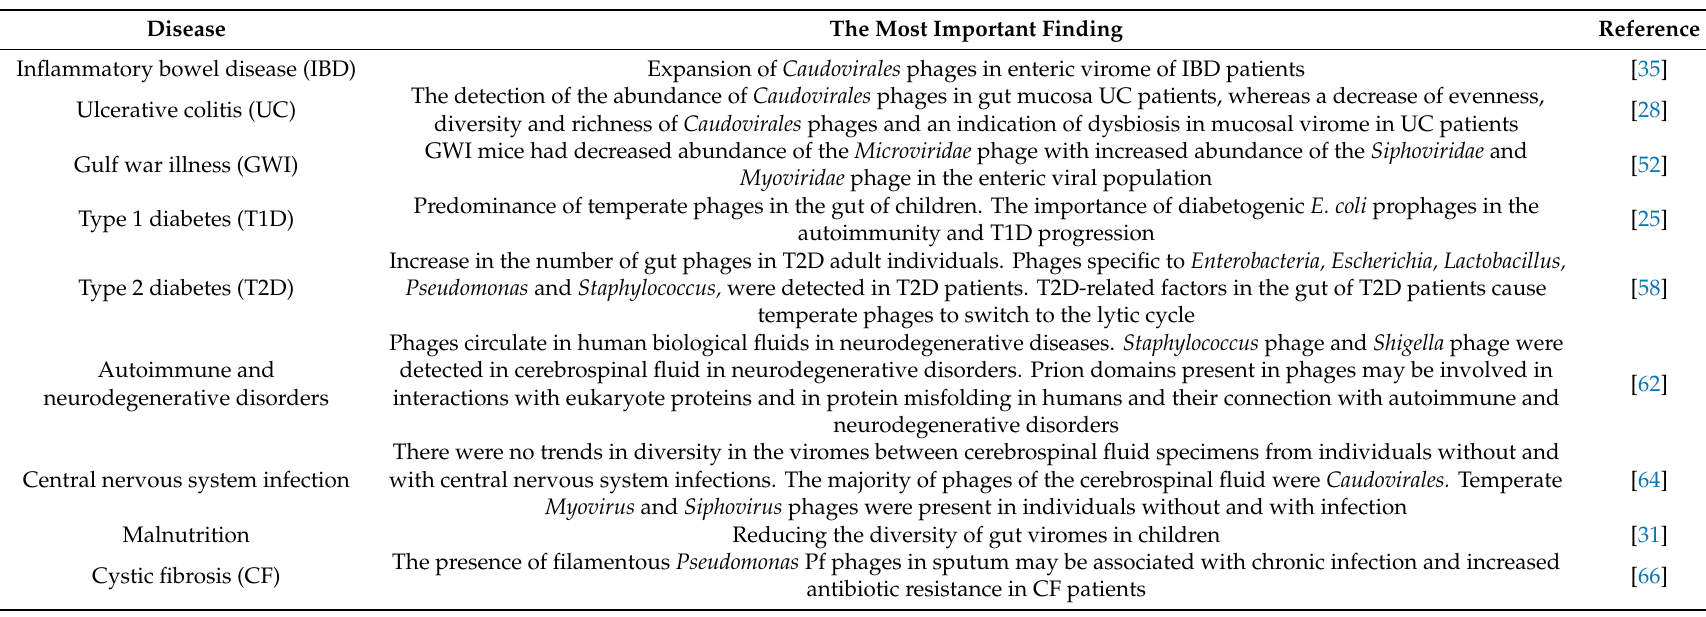
Table 1. Studies of phages in the human body in di ff erent